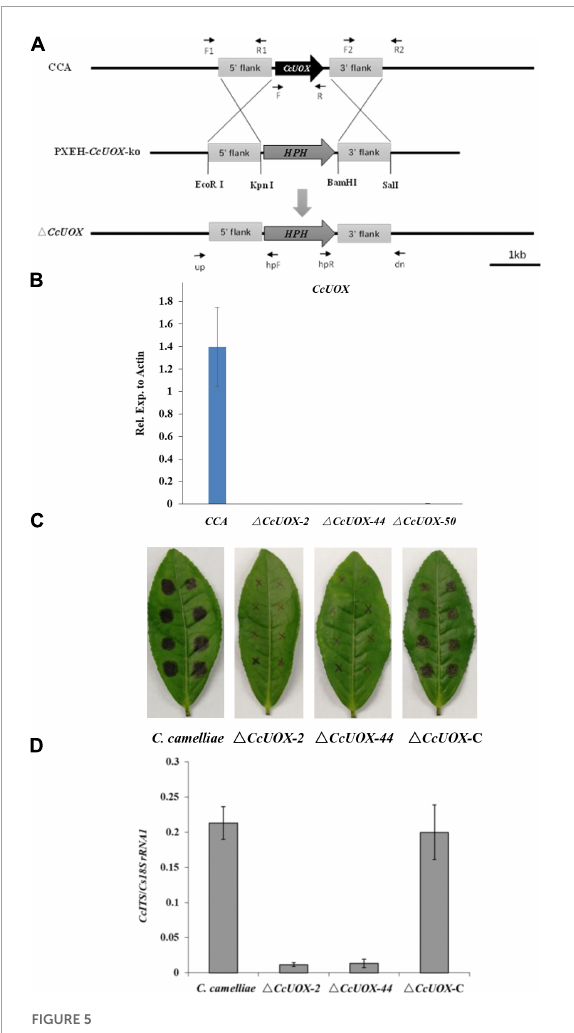
FIGURE5 C. camelliae CcUOX involves in fungal virulence. (A) Strategy for construction of CcUOX gene deletion mutants. (B)